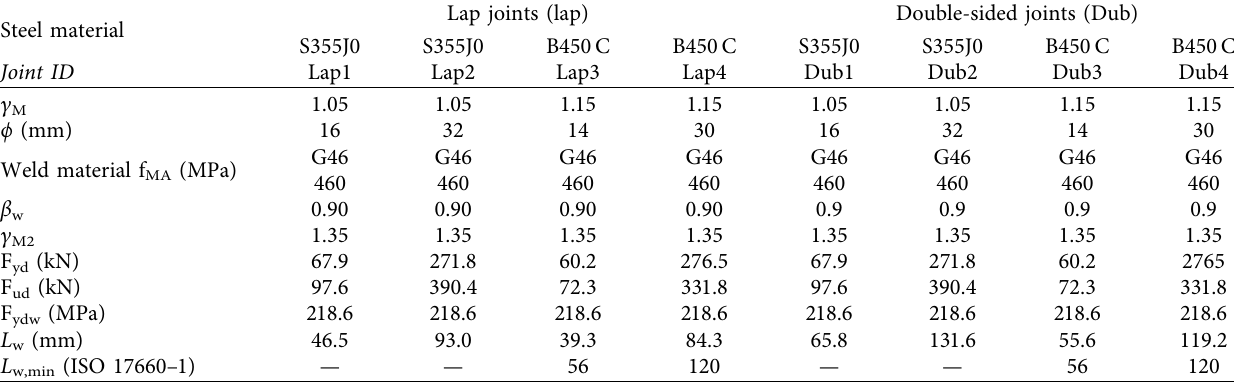
Table 1: Design characteristics of welded joints.